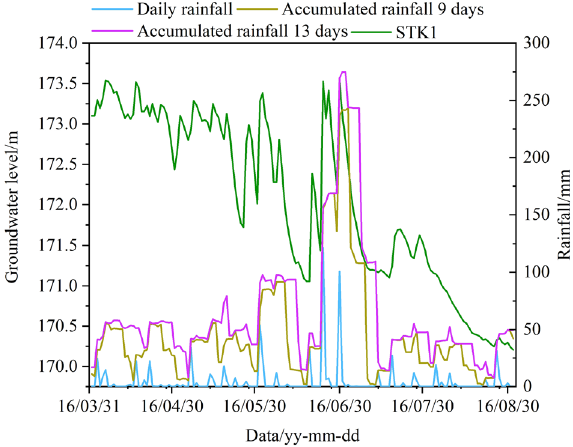
Figure 15. The curve chart of accumulated rainfall and groundwater level in STK1.